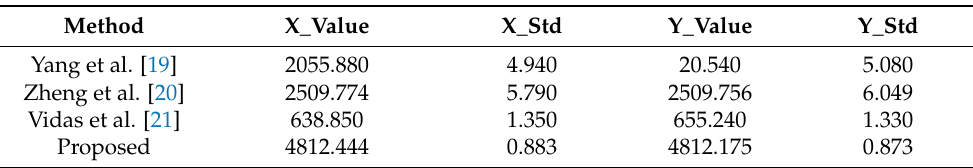
Table 3. Comparison of results obtained from different calibration methods (unit: pixels). “Proposed” represents the method proposed in this